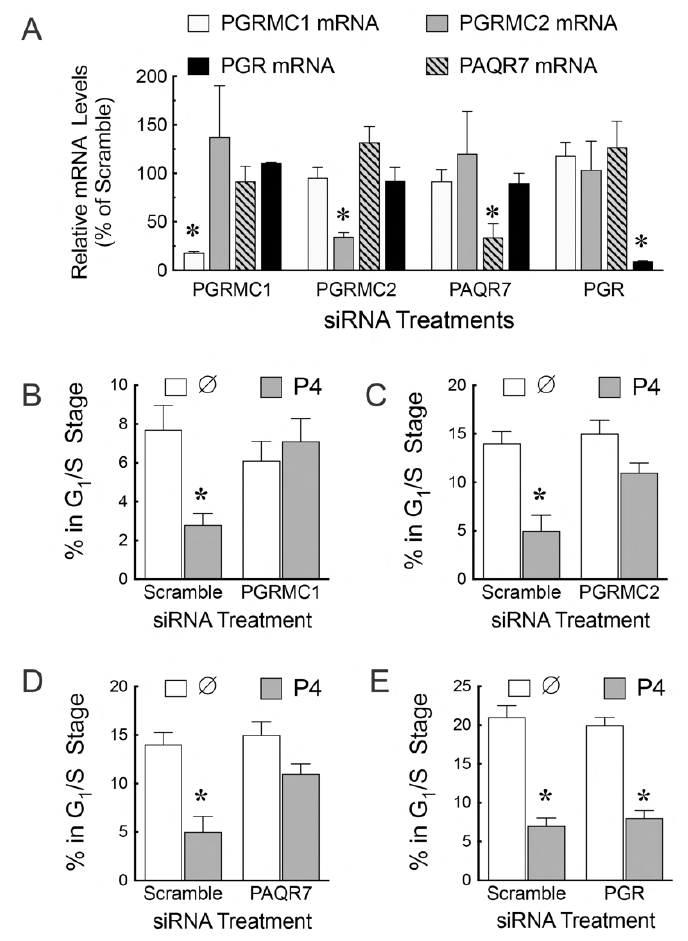
Figure 4. The effect of Pgrmc1 , Pgrmc2, siRNA treatment on the mRNA levels of Pgrmc1 , Pgrmc2 , Paqr7 , and Pgr. ( A ). The effect of progesterone (P4) and PGRMC1 siRNA ( B ), PGRMC1 siRNA ( C ), PAQR7 siRNA ( D ), and PGR siRNA ( E ) on the percentage of cells entering the G 1 /S stage of the cell cycle as assessed using the Fucci cell cycle indicator. Data taken from Sueldo et al. [61]. The ∅ identifies the no treatment control group. * indicates that P4 induced a significant decrease compared to the no treatment control.